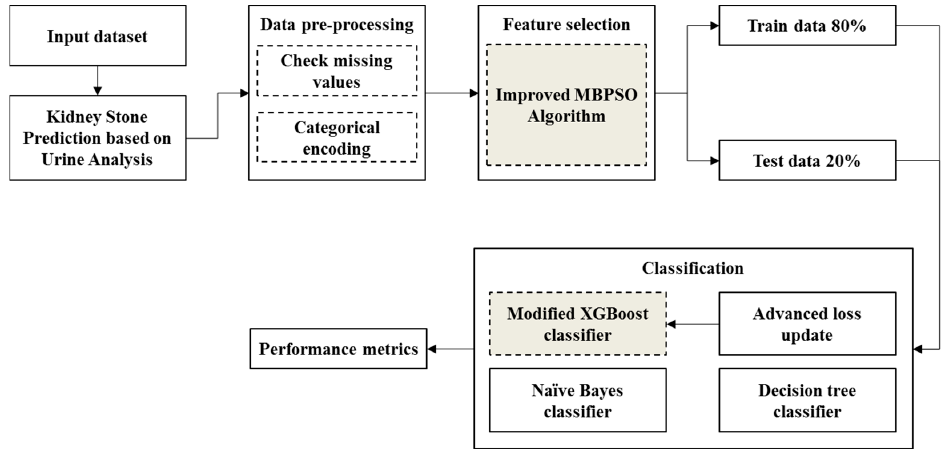
Figure 1. Overall fl ow of the proposed system.